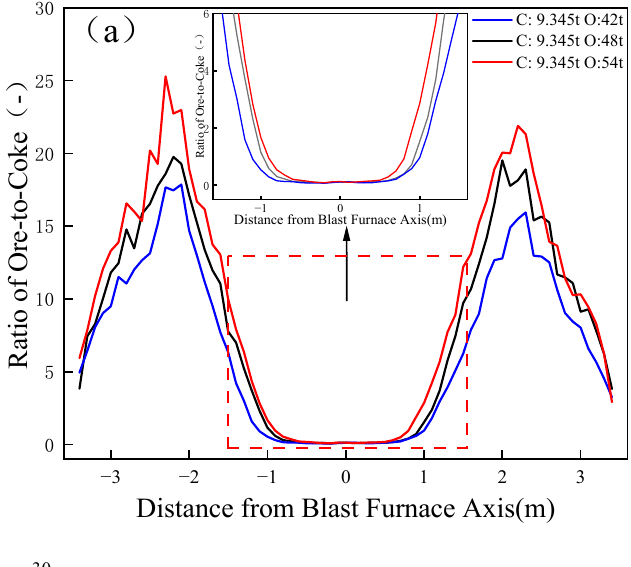
15 of 22 Figure 14. Burden distribution in the sampling area under di ff erent ore and coke batch weights. Figure 15 shows the curves of the ore–coke ratio of the two groups of experiments. In the case of only changing the ore batch weight, with the ore batch weight increased, the ore–coke ratio near the ore-free zone increased, resulting in a decrease in the area with high permeability in the center of the blast furnace, and the permeability deteriorated. The increase in the ore–coke ratio near the furnace wall is due to the increase in the ore quality,